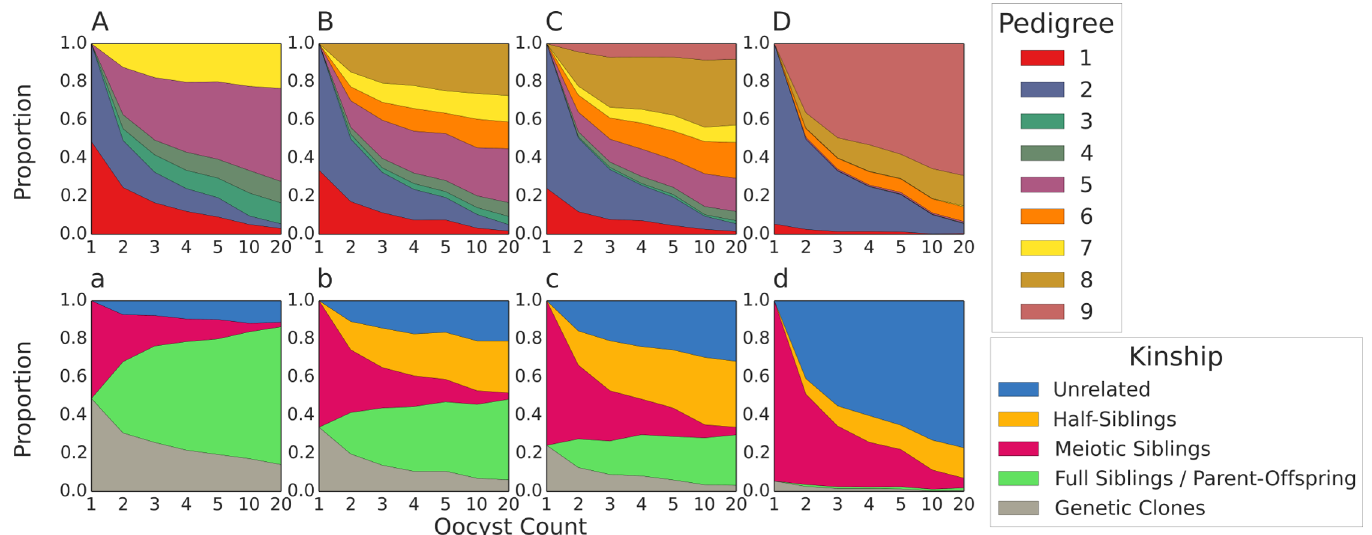
Fig 6. Pedigree and kinship frequencies from multiple oocyst simulations. Stacked line charts of the frequencies of different pedigrees (A-D) and kinships (a-d) plotted against oocyst count. Each subplot represents a scenario with a different COI (A/a = 2, B/b = 3, C/c = 4, D/d = 20). Only the results from simulations where infected hepatocyte count = 10 are shown. Genetic clones are defined as those emerging from oocysts characterized by pedigree 1 and 3; genetically identical meiotic siblings are still classified as meiotic siblings in this graph.